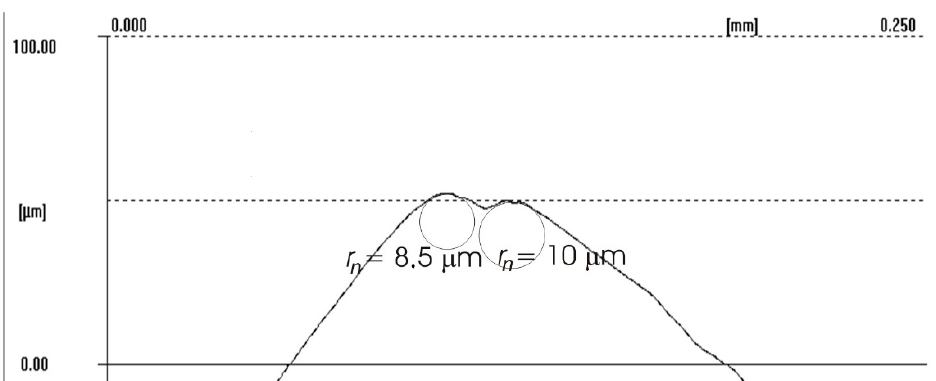
Figure 21. Cutting edge radius r n of the worn cutting insert after longitudinal turning with coolant (23 HRC).